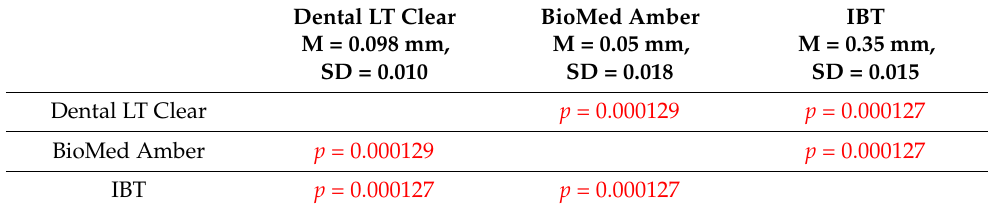
Table 9. ∆ L differences in the Tukey highly significant difference test (M—mean; SD—standard deviation; p — p -value; the statistical significance for p < 0.05 was presented in red). Dental LT